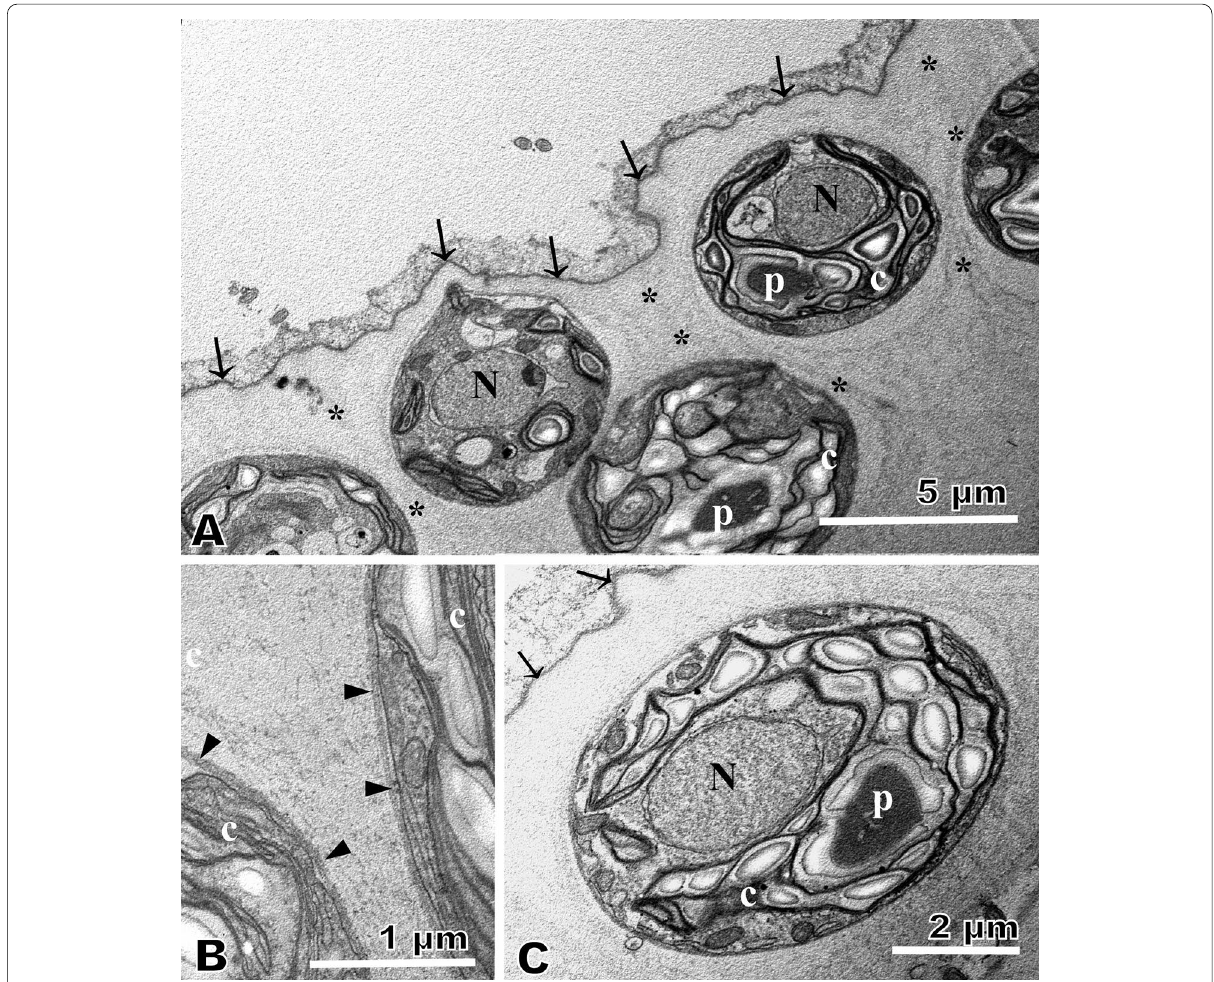
Fig. 3 Transmission electron microscopy of asexual spheroids of Volvox africanus G.S. West strain 1101-NZ-11 from Thailand. A – C Whole spheroid is surrounded by a tripartite layer (colonial boundary) of the extracellular matrix (arrows). Each protoplast is enclosed tightly by a thin layer (cellular envelope) of the matrix (arrowheads) and has a nucleus (N) and a chloroplast (c) with a pyrenoid (p). Note that the matrix between cells forms individual sheath (asterisks). A Section of peripheral region showing cells and extracellular matrix. B Details of cellular envelopes. C Longitudinal section of a